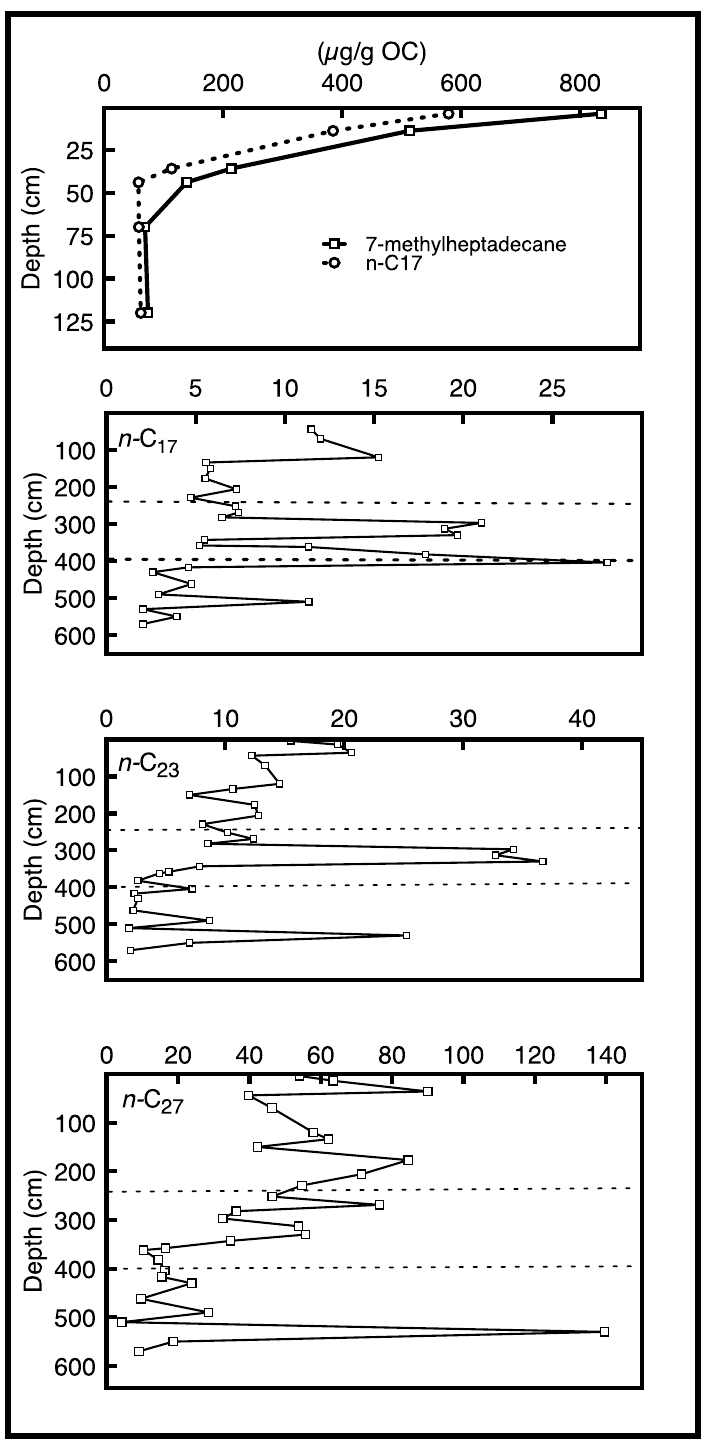
Fig 5. n -alkanes. Select n -alkane chain length abundances versus depth in the Lake Harris core. Dashed lines delineate core zones 1–3.